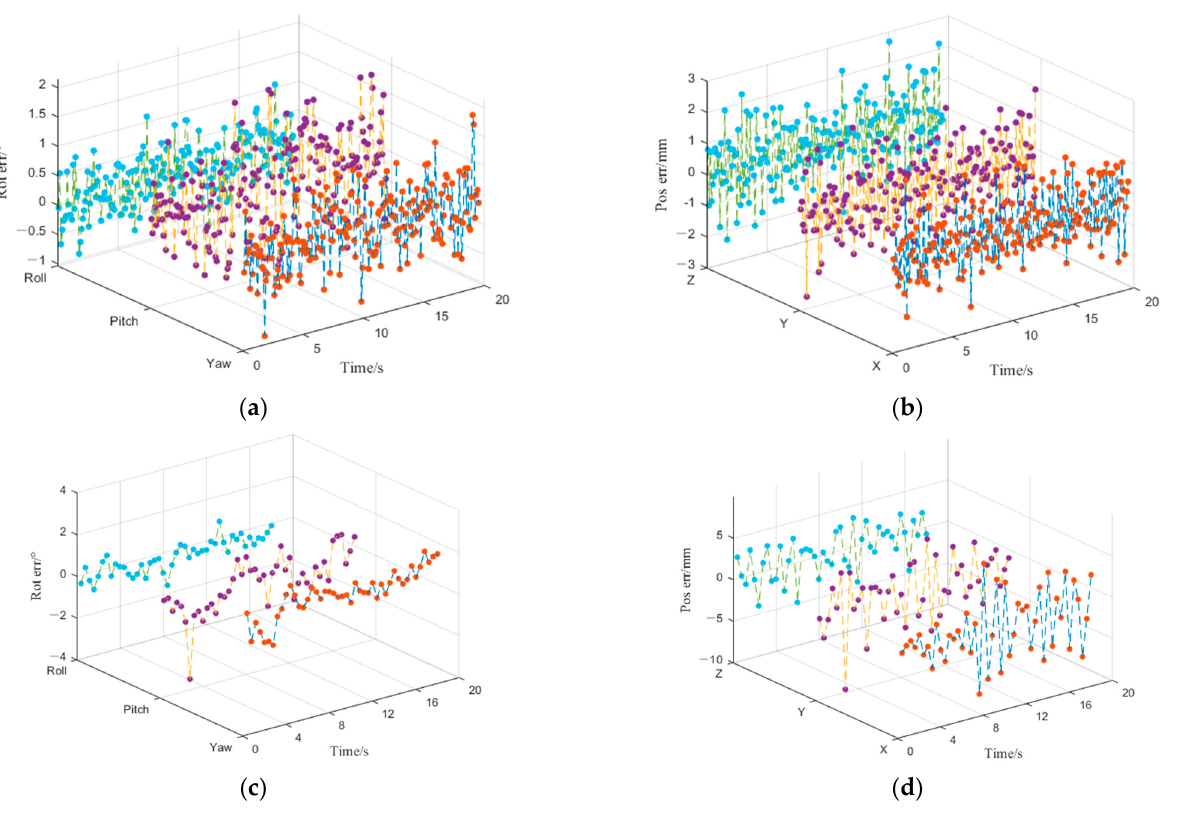
Figure 7. Pose estimation accuracy at the different measurement frequencies. ( a ) Attitude meas ‐ urement error at 10 Hz; ( b ) Position measurement error at 10 Hz; ( c ) Attitude measurement error at 2.5 Hz; ( d ) Position measurement error at 2.5